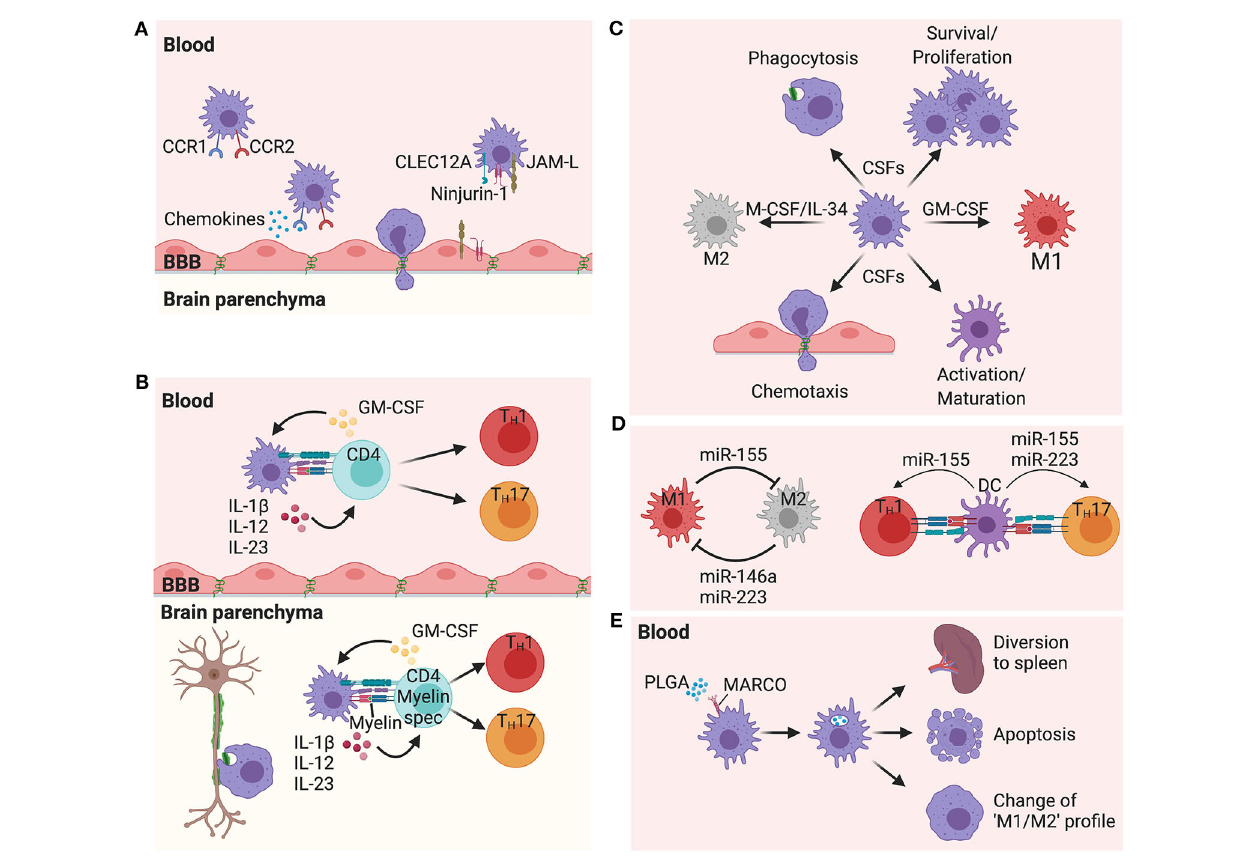
FIGURE 1 | Proposed mechanisms of peripheral myeloid cells in multiple sclerosis pathogenesis. (A) Chemokine receptors CCR1 and CCR2, as well as the adhesion molecules Ninjurin-1 and JAM-L, and the C-lectin receptor CLEC12A have all been shown to play important roles in myeloid cell migration from the periphery to the CNS. (B) Interactions between myeloid cells and CD4T cells are critical to shape the type of immune response. These interactions take place in the periphery as well as in the CNS. Cytokines such as IL-1 β , IL-12, and IL-23 produced by myeloid cells and GM-CSF produced by activated CD4T cells are all attractive targets for MS therapy, playing critical roles in the CNS inflammation. (C) M-CSF (CSF-1)/IL-34 and GM-CSF (CSF-2) are upregulated during inflammation and control many different functions on myeloid cells such as differentiation, phagocytosis, chemotaxis, activation, polarization, and survival. Blockade of the receptors of these growth factors are intriguing therapeutic options in MS. (D) miRNAs have the ability to regulate the function of many cells, including myeloid cells. miR-223, − 155, and − 146a have all shown to be upregulated in MS lesions, and are expressed by myeloid cells. While miR-146a and miR-223 promote an M2 profile, miR-155 promotes an M1